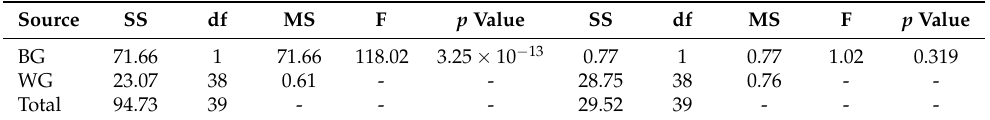
Table 4. Using the RRSYNTH dataset, the ANOVA results of the left side columns were obtained from the SVRMF and CASVR; the right side columns were obtained from LSTMMF and CALSTM models, where SS denotes a sum of squares, df is the degree of freedom, MS is the mean squared error, BG is between groups, and WG indicates within groups.